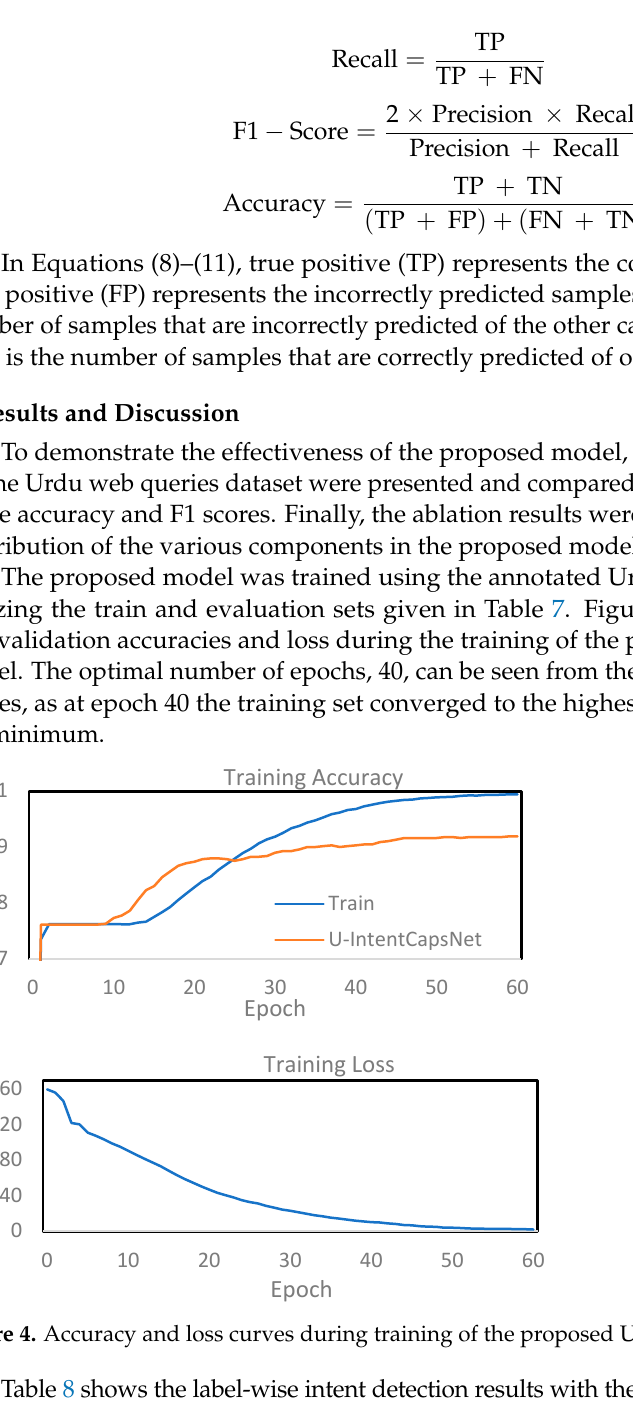
Table 8. Intent detection results with respect to the web query’s intent.